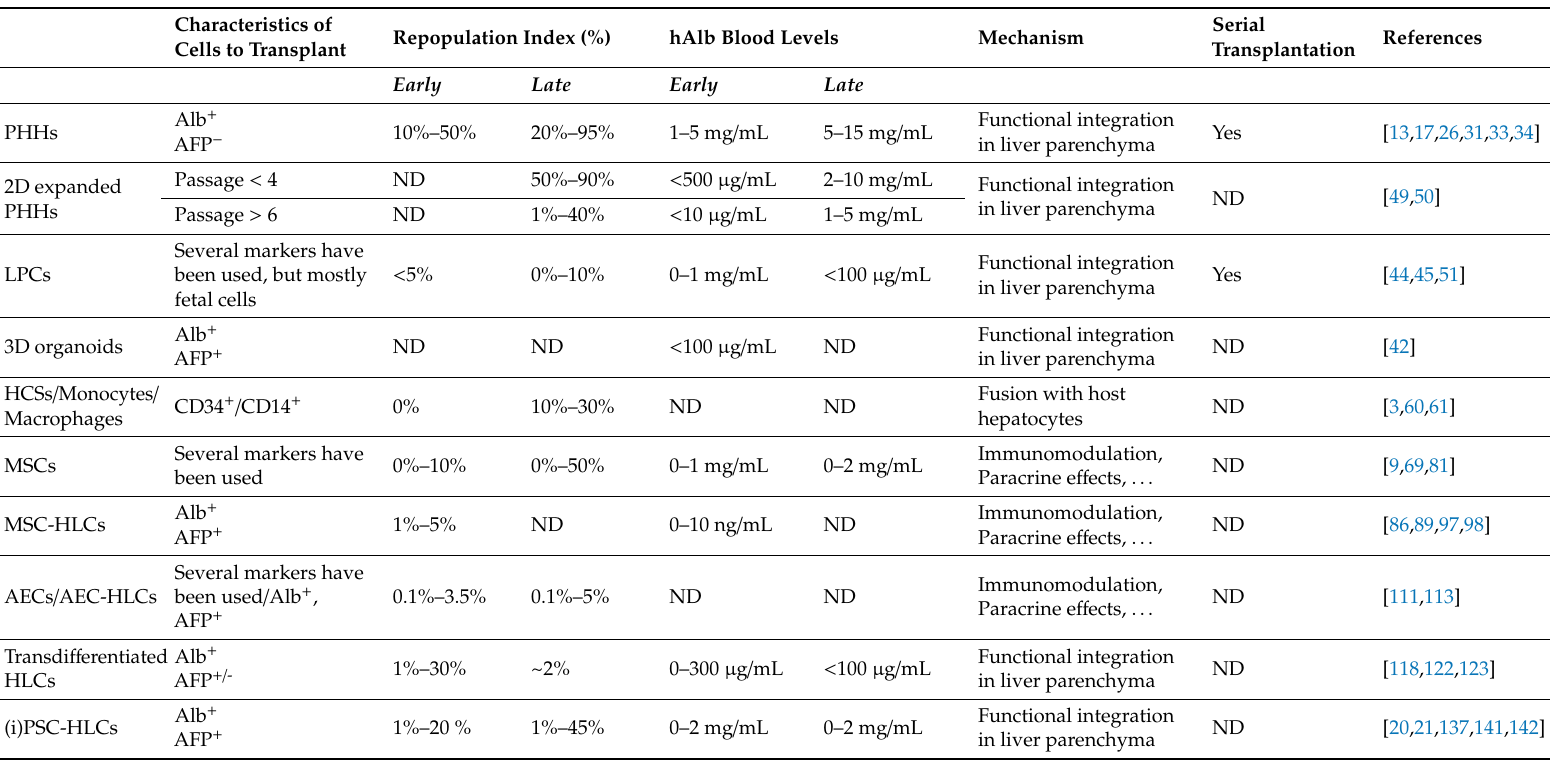
Table 2. General overview of hepatocyte transplantations in pre-clinical animal models as described in the main text and grouped per cell type. Other di ff erences, like di ff erences in animal models, route of cell administration, and di ff erentiation protocol, were not considered. Late = 2 months or more, Early = less than 2 months, ND = no data